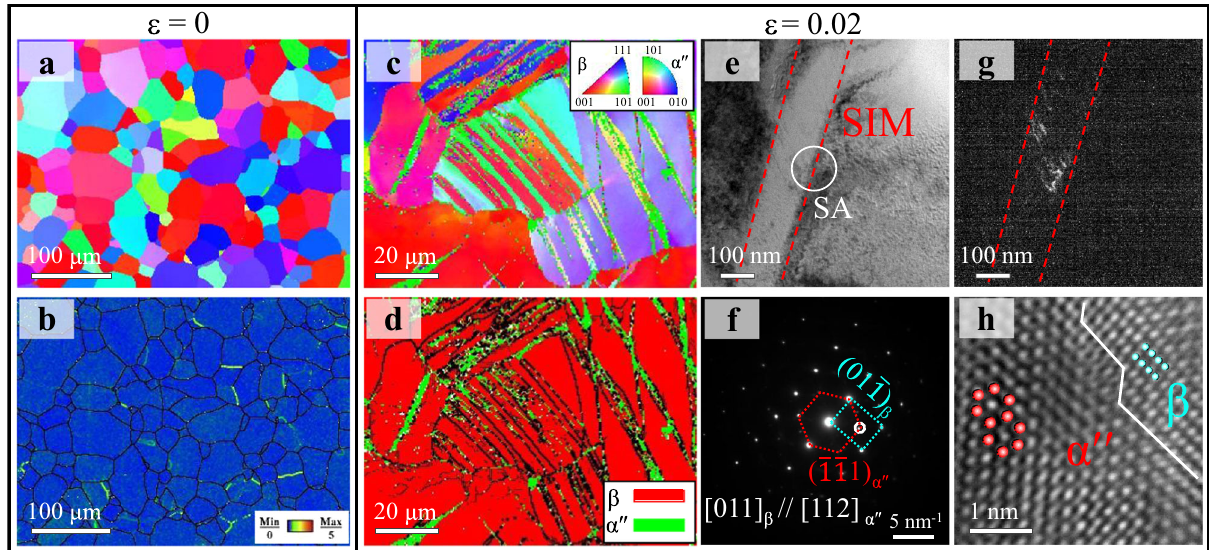
Fig. 2 | Deformation mechanisms of the EGS-61 β -Ti alloy at the initial stage of plastic deformation. At a strain ɛ =0, a the inverse pole fi gure (IPF) image and b the corresponding kernel average misorientation (KAM) image. c At a strain ɛ =0.02, the IPFimage shows the plate-likedeformation bandsthatwere identi fi ed